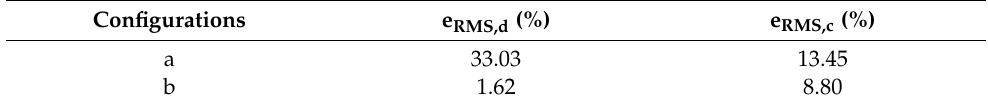
Table 2. Root-mean-squares of the displacements and